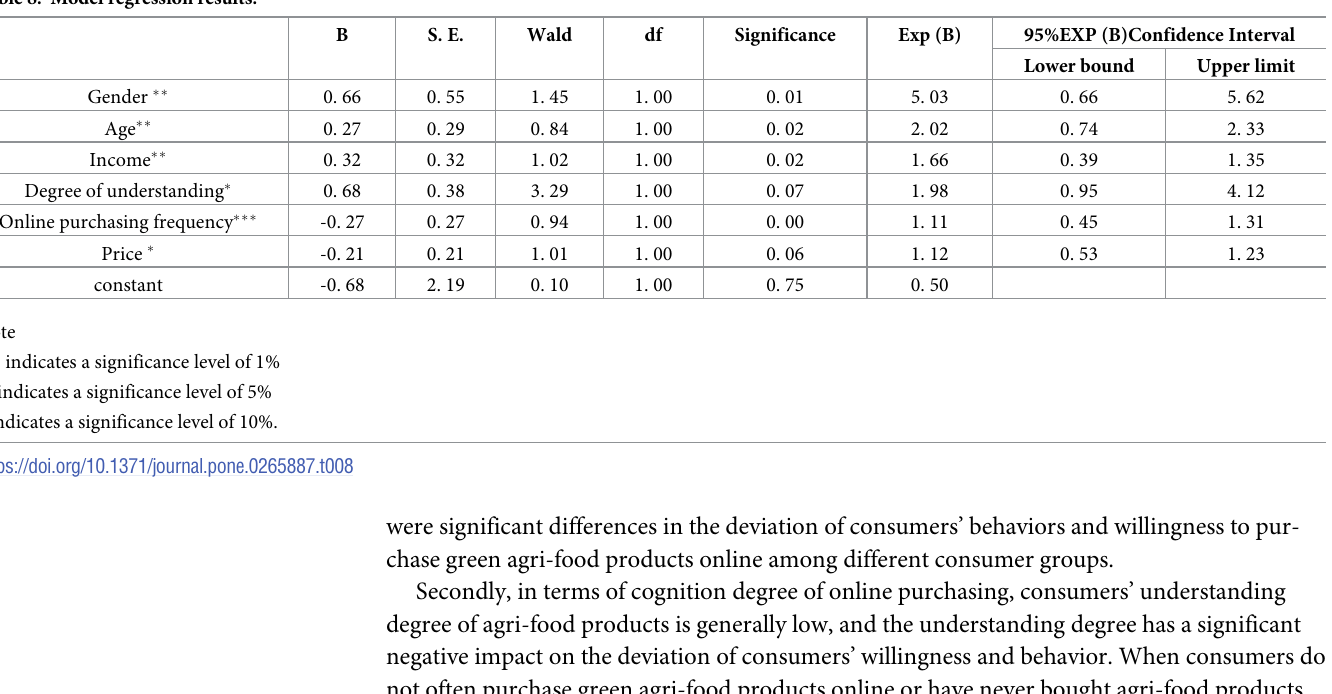
Table 8. Model regression